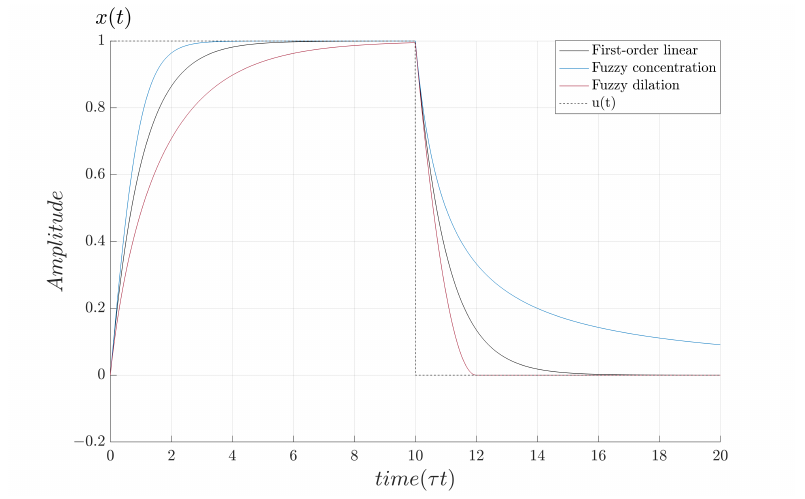
Figure 8. Step response, with normalised time τ t , for K = 1.